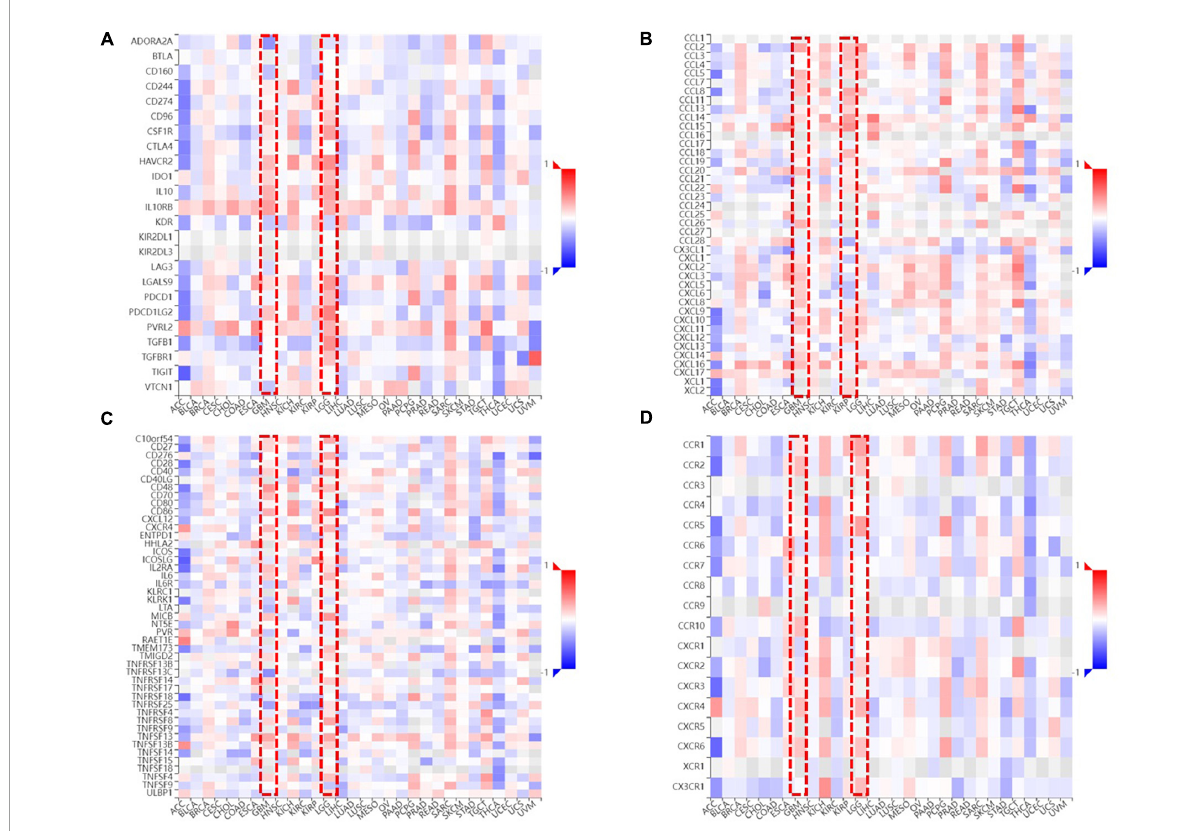
FIGURE9 The relationship between FDX1 and immune-related genes expression. (A) The relationship between FDX1 and immunosuppressive genes expression in glioma. (B) The relationship between FDX1 and glioma immunostimulatory genes expression in glioma. (C) The relationship between FDX1 and chemokine genes expression in gliomas. (D) The relationship between FDX1 and receptor genes expression in glioma.